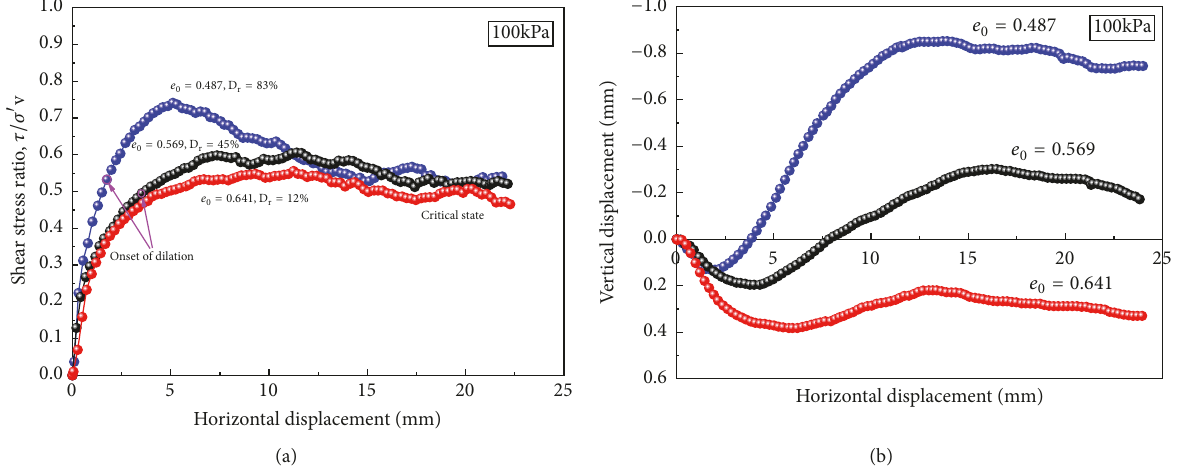
Figure 5: Experimental results of stress-strain response (100 kPa). (a) Shear stress ratio-horizontal displacement curve. (b) Vertical displacement-horizontal